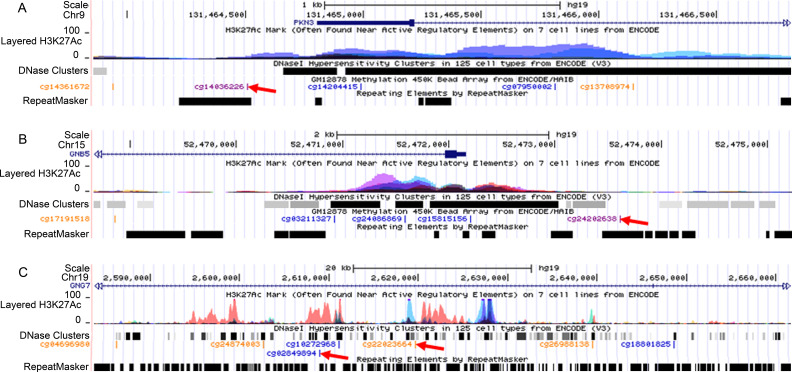
Genomic location of significant differentially methylated retrotransposons.(A) Protein Kinase N3 (PNK3). (B) G Protein Subunit β 5 (GNB5). C) G Protein Subunit γ 7 (GNG7). Red arrows indicate DMPs identified by the study.